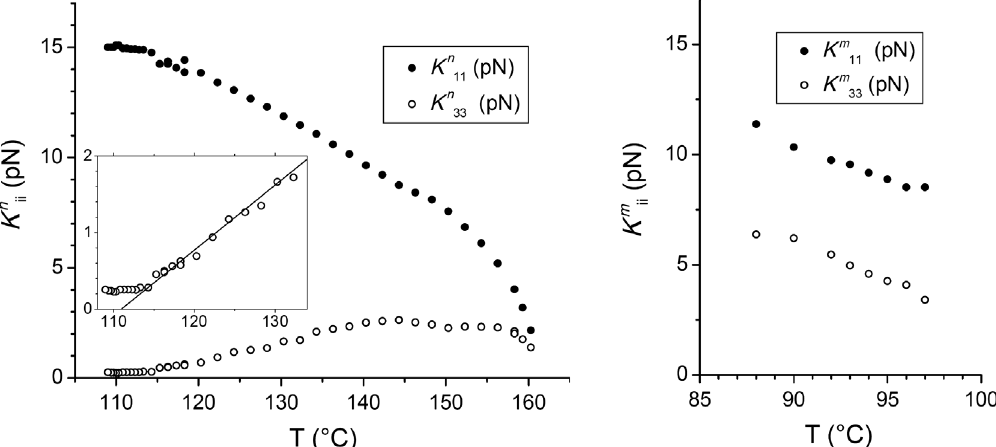
FIG. 12. Temperature dependence of the splay and bend elastic constants in the N (a) and Sm A inset in (a) shows a magnification of the K n 33 curve.]